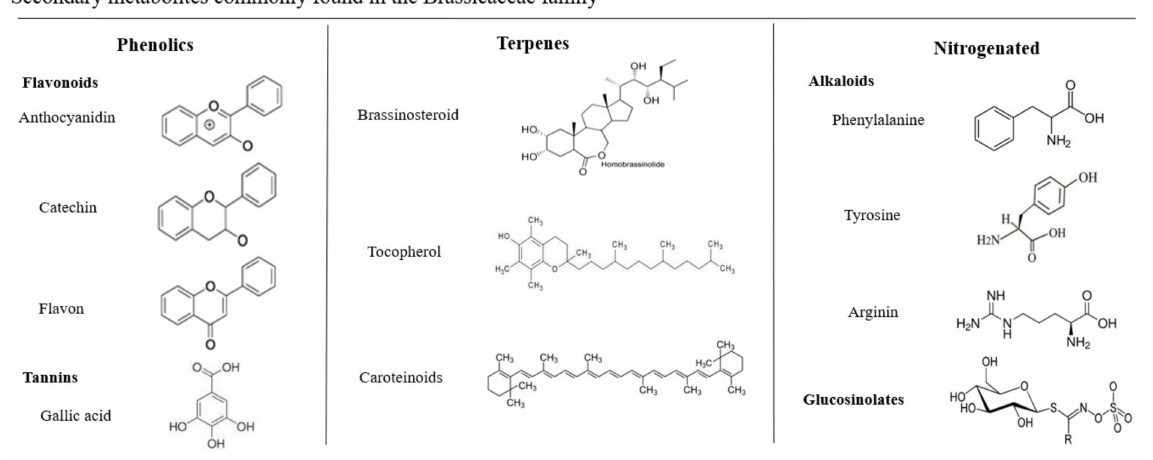
Figure 6. Secondary metabolites commonly found in the Brassicaceae family: phenolics, terpenes, and